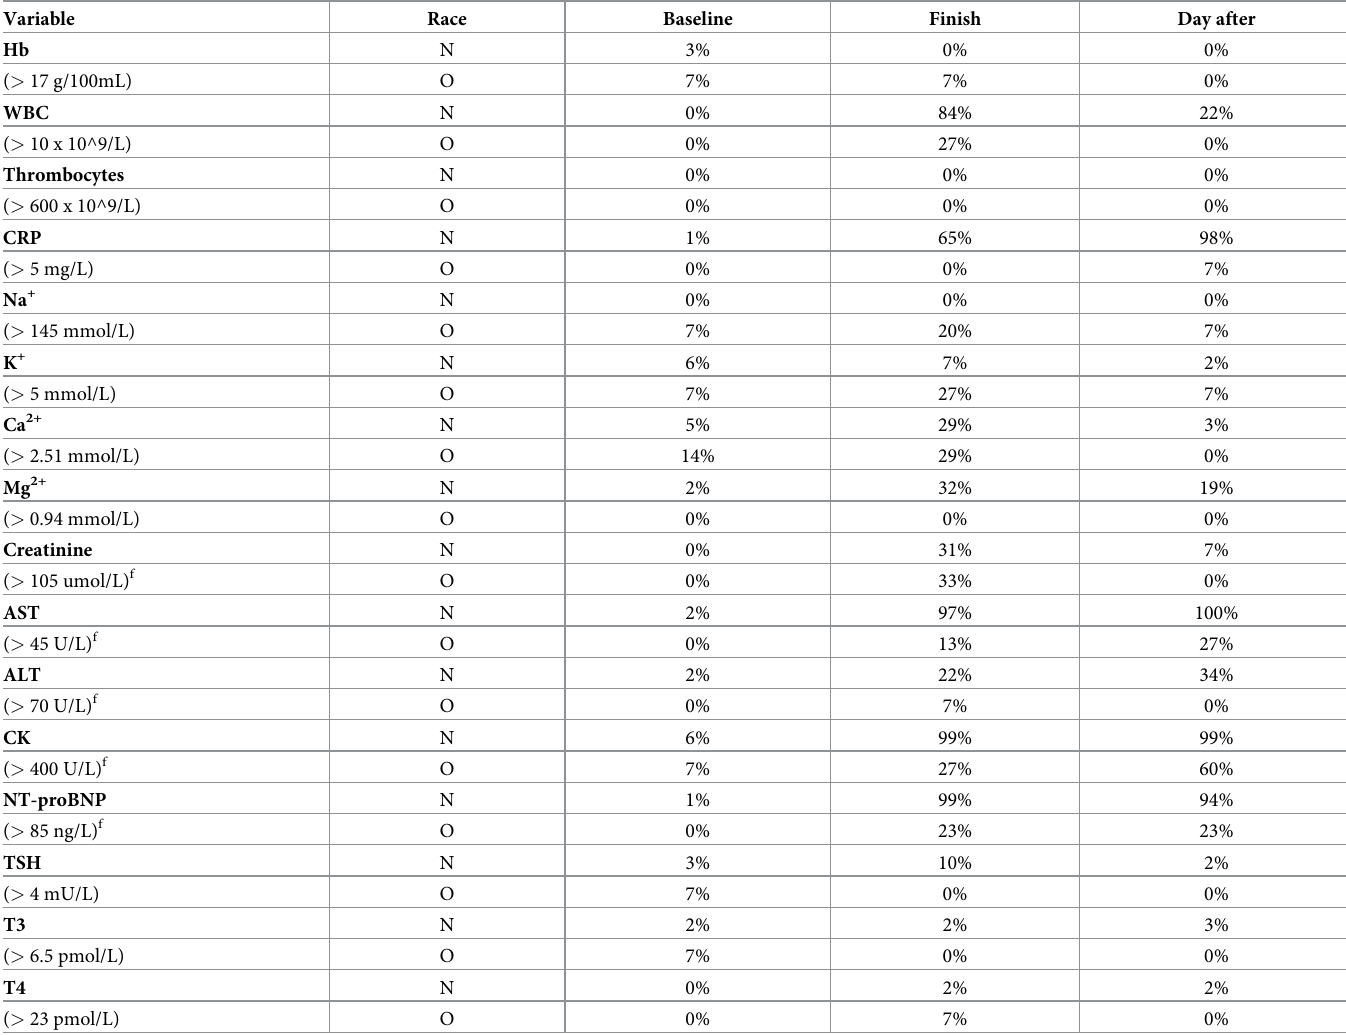
Table 3. Percentage athletes above reference